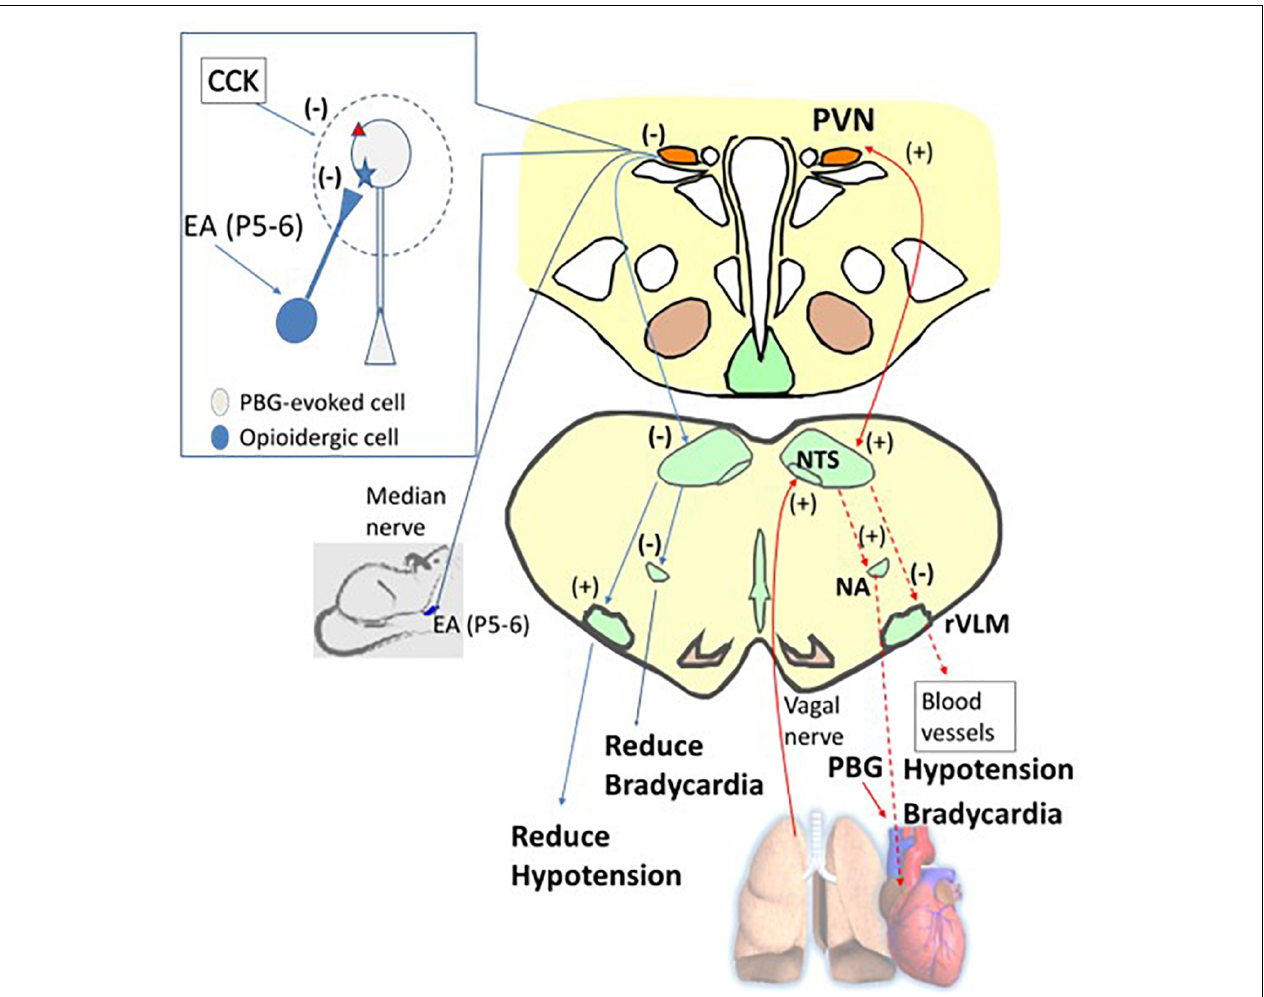
FIGURE 9 | A diagram displays the afferent (the solid red arrow) and efferent (the dashed red arrow) nerves and projections involved in phenylbiguanide (PBG) induced cardiopulmonary reflex response modulated by electroacupuncture (EA). For ease of display, on the right is the PBG-related neuronal pathway (red arrows), while on the left is the reversal of the evoked activities, leading to reduction of hypotension and bradycardia by EA inhibition (blue arrows). The dialogue box on the left shows opioid and CCK systems observed in non-responders. The opioid receptor is shown as a blue star and the CCK receptor as a red triangle. PVN, paraventricular nucleus; NTS, nucleus tractus solitaries; rVLM, rostral ventrolateral medulla; NA, nucleus ambiguus. ( + ), excitatory projection. (–), inhibitory projection. NTS-rVLM, inhibitory projection through GABAergic cVLM neurons. NA-Heart, inhibitory projection through acetylcholinergic